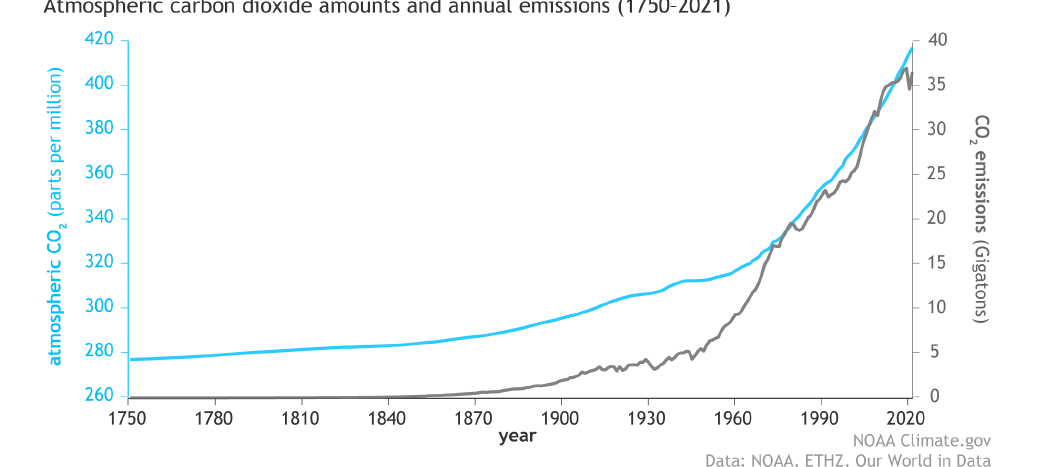
Figure 8. Atmospheric CO 2 amounts and annual emissions [75].